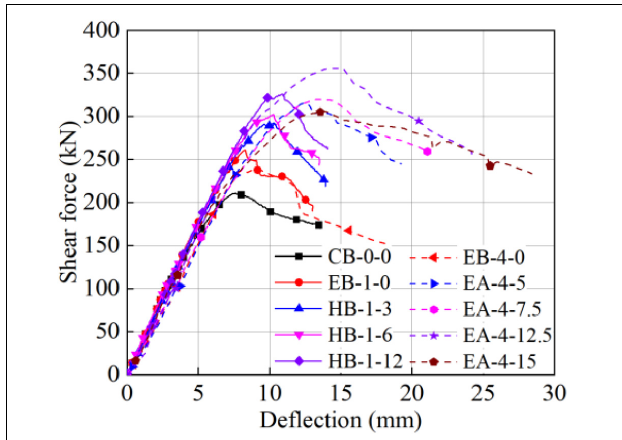
FIGURE 7 | Shear force vs. deflection curves.